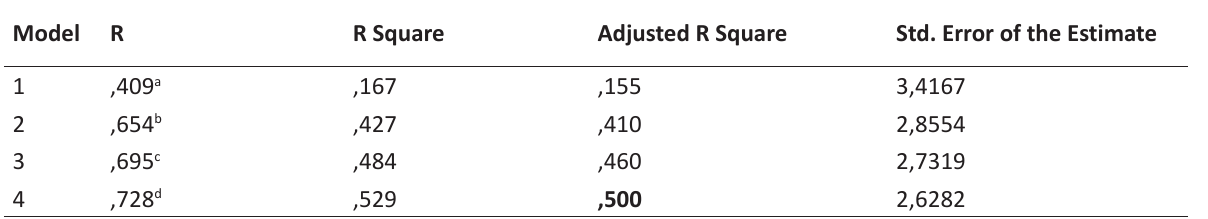
Table 2. Regression model evaluation regression analysis for estimation of fat%